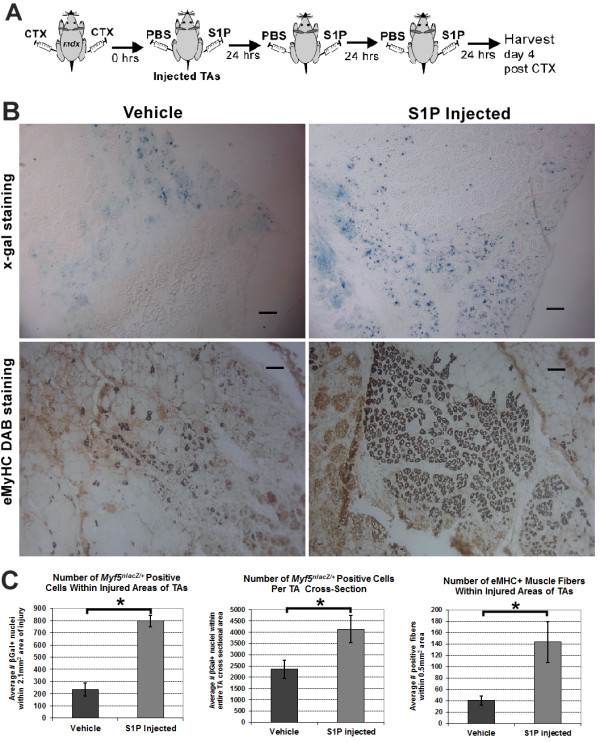
Direct administration of S1P promotes muscle regeneration following acute injury. (A) Experimental schematic of S1P and PBS (vehicle) injected daily for the first 72 hours into TAs of 3-MO mdx4cv:Myf5nlacZ/+ mice (n = 3, left TAs injected S1P, right TAs injected PBS) following CTX injury. (B) Top row: X-gal staining reveals an increased number of β-galactosidase+ nuclei at the sites of injury in S1P-treated TA muscles compared to vehicle controls. Bottom row: staining for eMyHC with DAB reveals a significant increase in the number of newly regenerated muscle fibers in S1P-treated TA muscles. Scale bars = 50 μm. (C) Left graph: quantification of β-galactosidase+ nuclei indicates the number of Myf5+ cells is significantly increased at the site of injury in S1P-treated compared to untreated muscles. Middle graph: a significant increase in β-galactosidase+ nuclei was also observed over the entire CSA of each S1P-treated TA muscle. Right graph: quantification of the number of eMyHC fibers within areas of regeneration was significantly greater with S1P treatment. *P <0.05 by student’s t-test. Error bars represent SEM. CSA, cross-sectional area; CTX, cardiotoxin; DAB, 3,3'-diaminobenzidine; eMyHC, embryonic myosin heavy chain; MO, month-old; S1P, sphingosine-1-phoshate; SEM, standard error of the mean; TA, tibialis anterior.